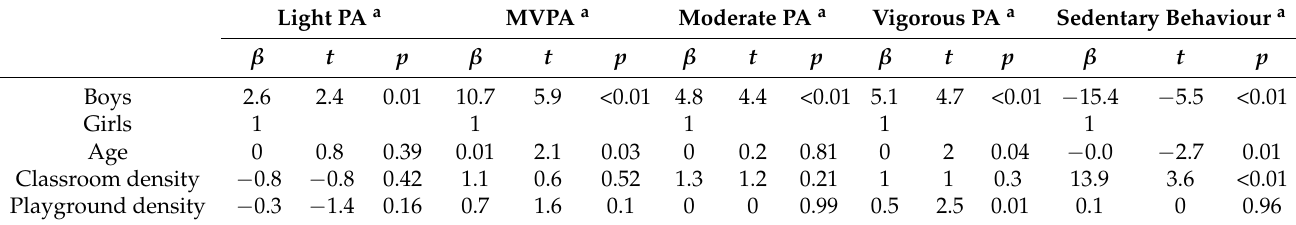
Table 4. Mixed-model regression results for relationship between independent variables and physical activity levels during school hours in preschoolers, according to